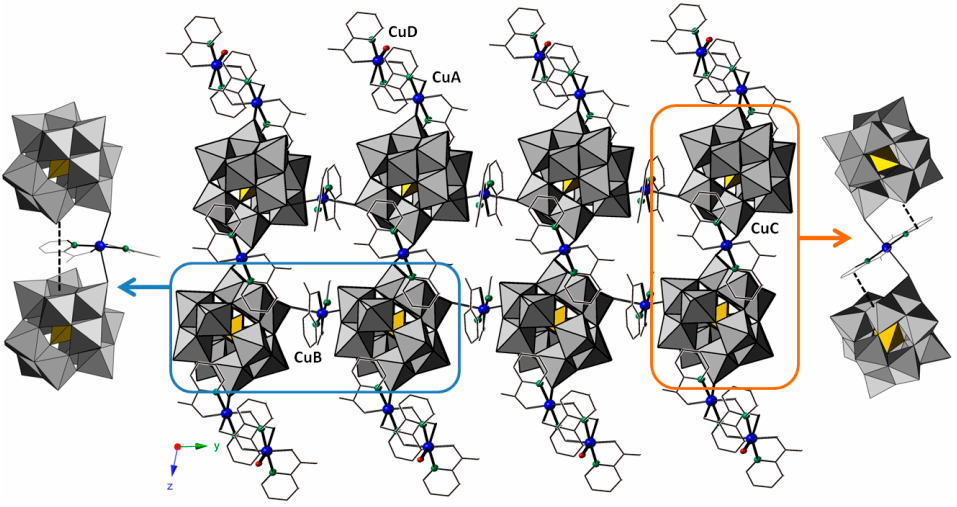
Figure 5. Projection of a [{SiW 12 O 40 } 2 {Cu(pic) 2 } 3 ] n 8 n − double chain decorated with {Cu 2 (pic) 4 (H 2 O)} antenna complexes on the crystallographic bc plane and details of the POM–aromatic interactions involving the bridging {Cu(pic) 2 }